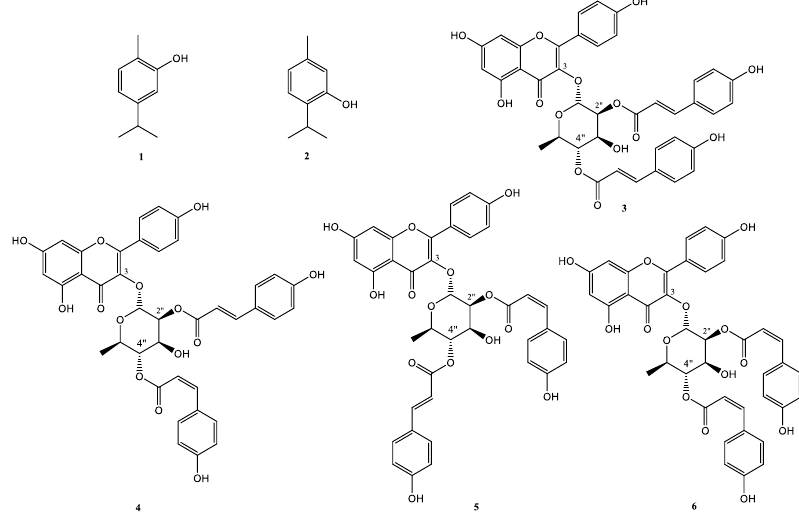
Figure 3. Chemical structures of isolated compounds 1 – 6 .